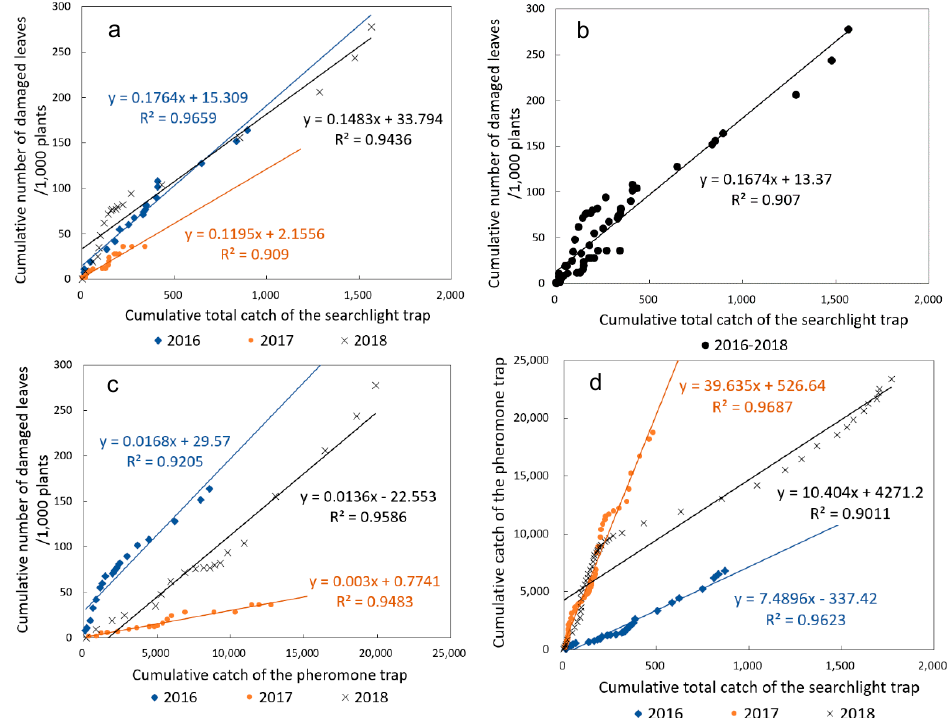
Figure 7. Linear regression analysis of cumulative total catch numbers and numbers of damaged leaves. ( a ) Linearity between the cumulative total catch number of the searchlight trap and the cumulative number of damaged leaves at ds = 4 for each year. ( b ) Linearity between the cumulative total catch number of the searchlight trap and the cumulative number of damaged leaves at ds = 4 for 2016–2018. ( c ) Linearity between the cumulative catch number of the pheromone trap and the cumulative number of damaged leaves at ds = 4. ( d ) Linearity between the cumulative catch numbers of the pheromone trap and the searchlight trap in August and September.